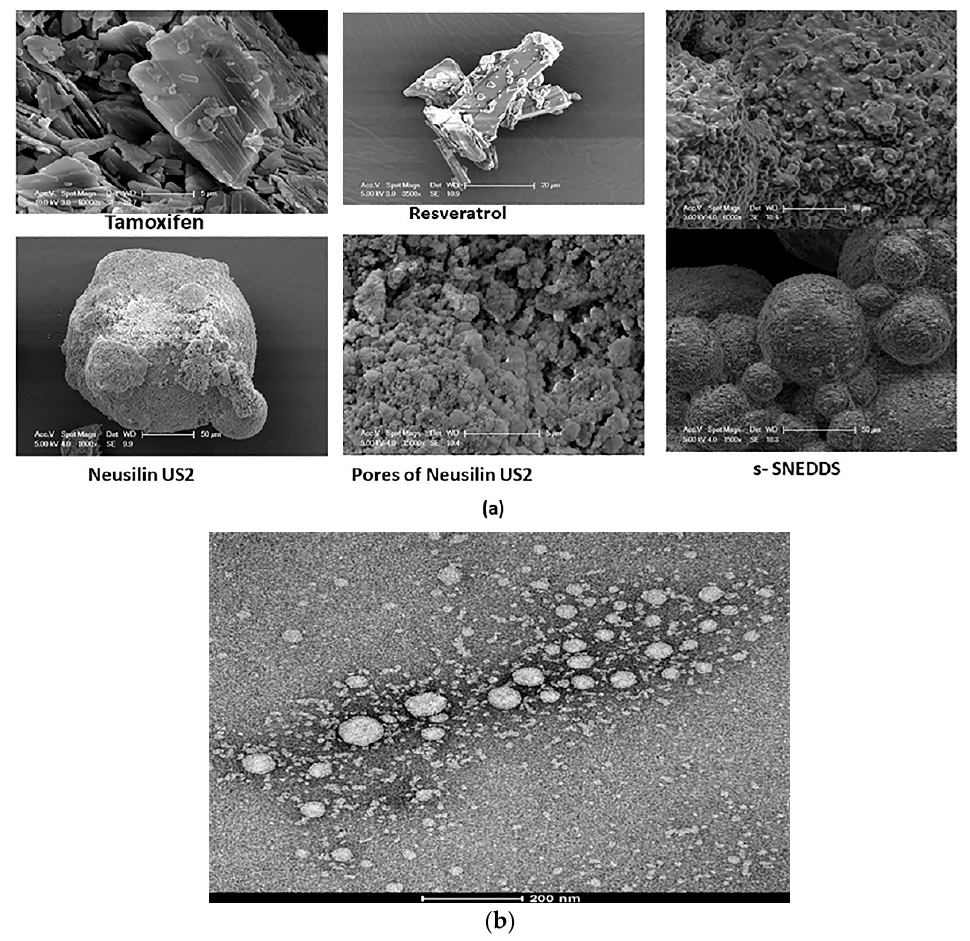
Figure 5. Surface morphology of ( a ) TAM, RES, neusilin US2 and s-SNEDDS by SEM. ( b ) s-SNEDDS by TEM depicting the spherical shape of the droplets.